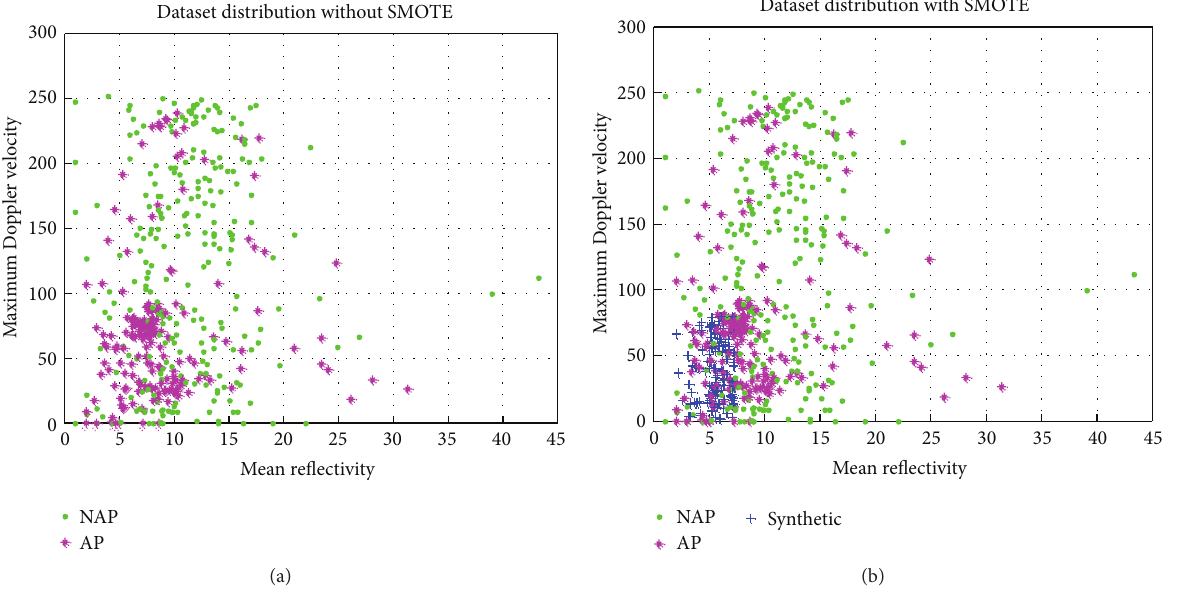
Figure 7: Radar data distribution: (a) without SMOTE algorithm and (b) with SMOTE algorithm.